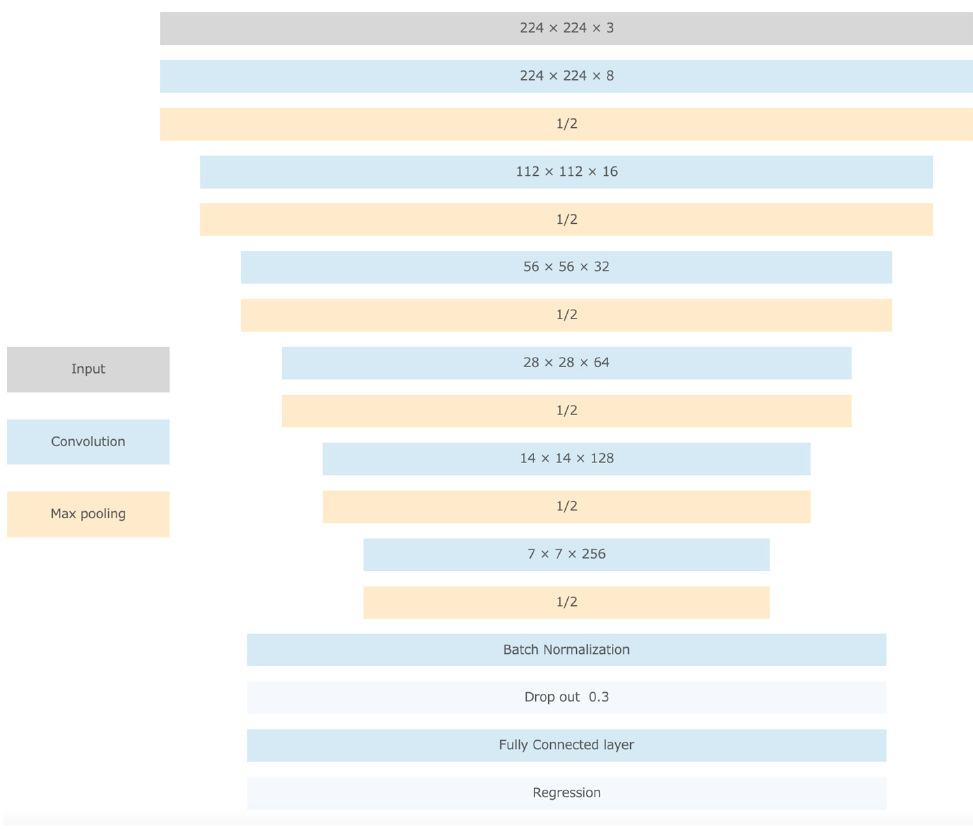
Figure 2. Outline of the original convolutional neural network.